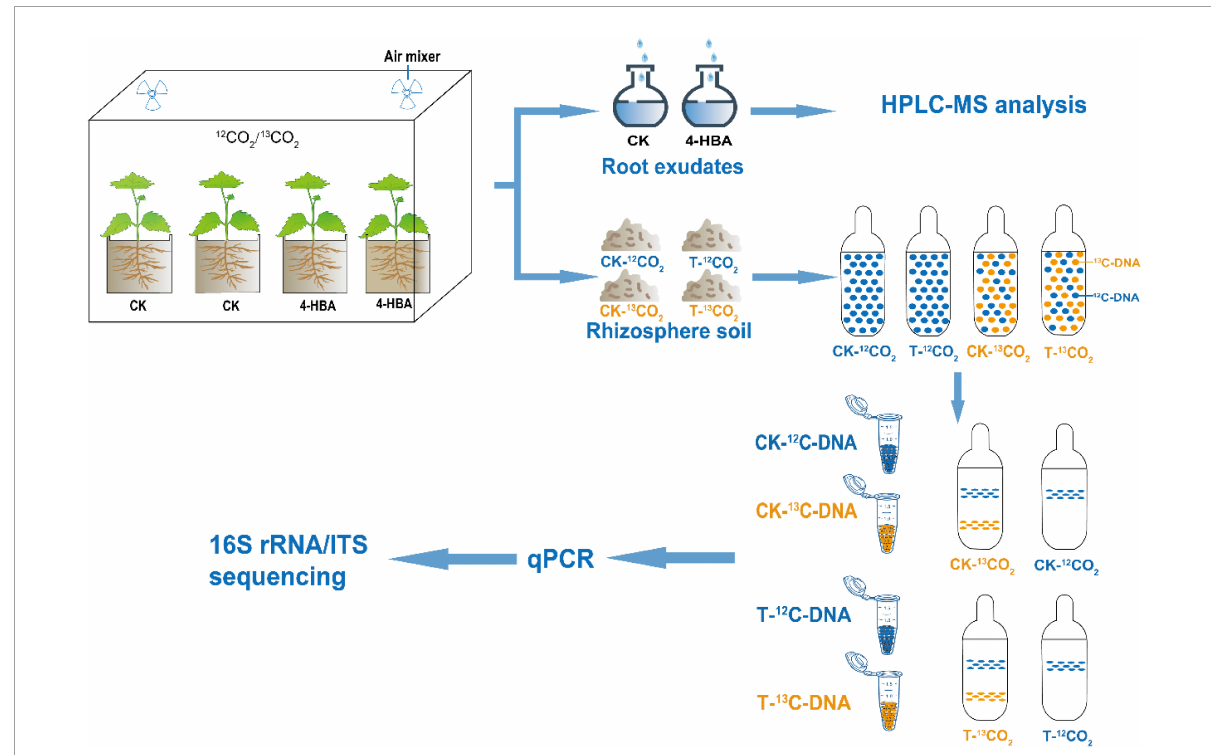
FIGURE1 Schematic representation of the experimental approach used for identifying the active microbiome associated with rhizosphere soil of